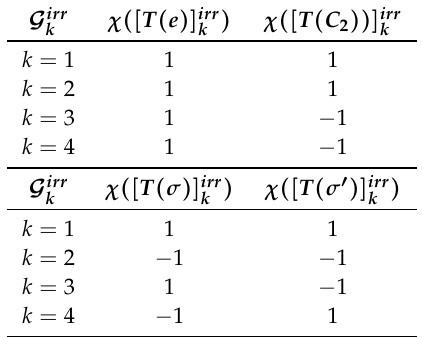
Table 1. Character table for the irreducible representations G irr